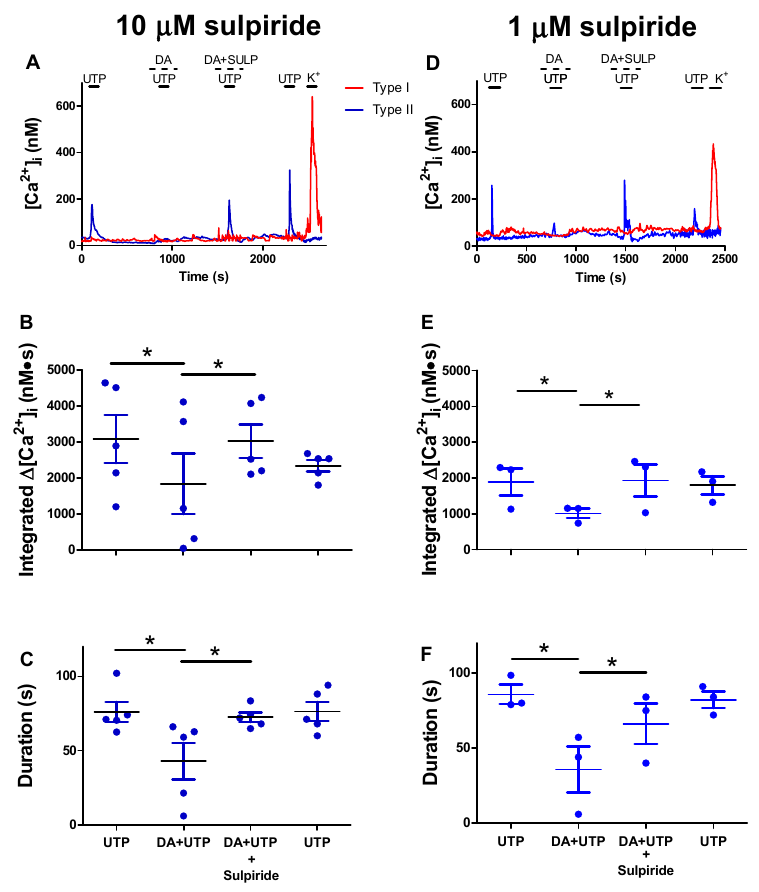
Figure 2. Sulpiride, a D2/3R antagonist, reverses the inhibitory effect of dopamine on the UTP-evoked intracellular Ca 2+ rise in type II cells. ( A , D ) Representative type I and type II cell traces showing